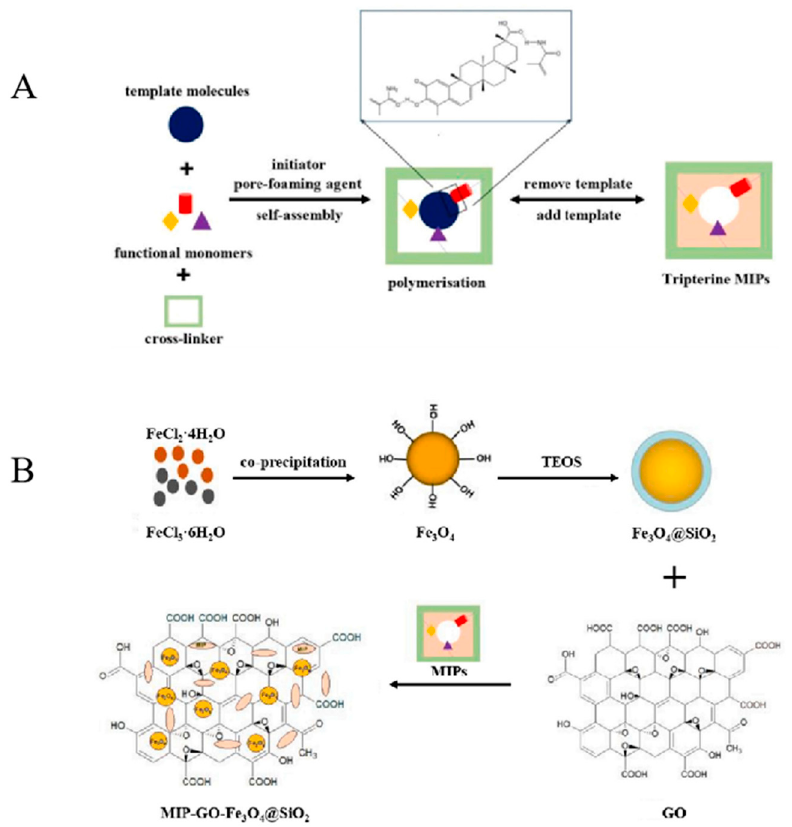
Figure 6. ( A ) The preparation and application process of MIPs. ( B ) The preparation process of magnetic graphene oxide molecularly imprinted polymers (MIPs-GO–Fe 3 O 4 @SiO 2 ) [65].